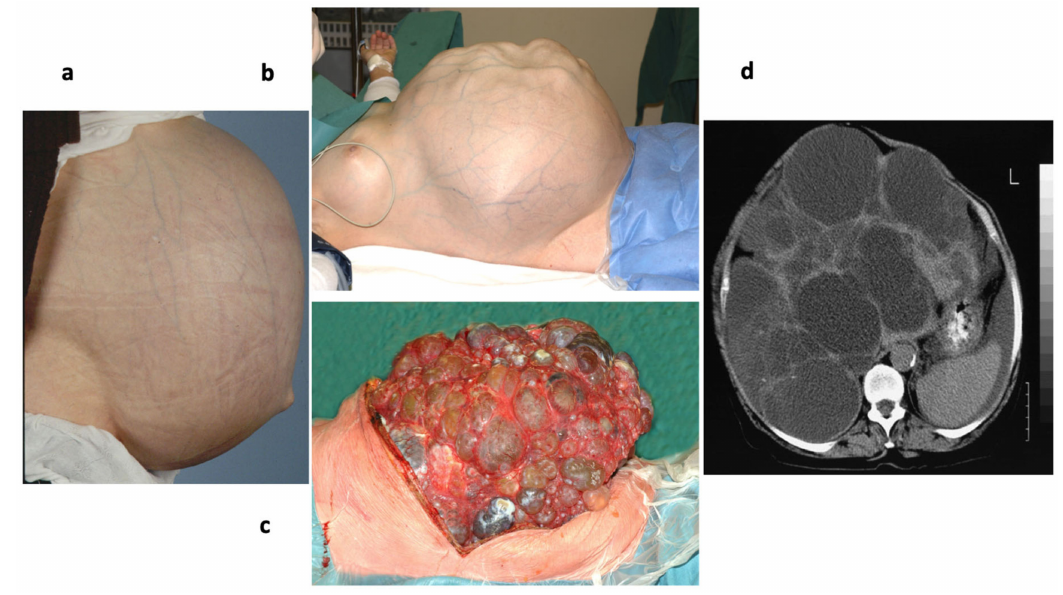
Figure 7. Autosomal dominant polycystic liver disease. Photographs of various ADPLD patients are shown in ( a – c ). ( d ) represents a computer tomogram of another